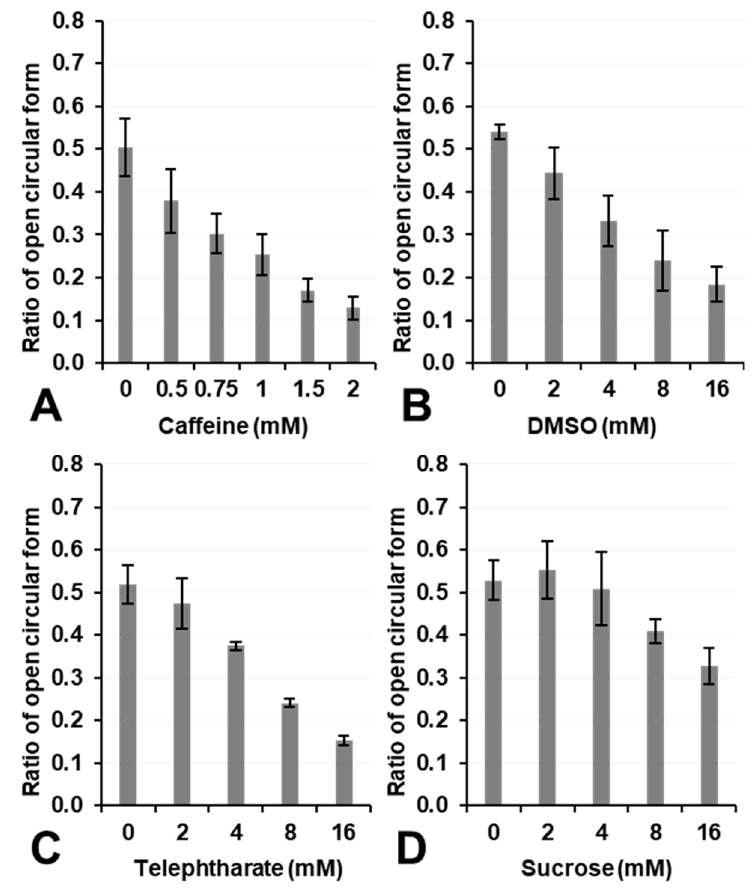
Figure 7. Effects of • OH scavengers on plasmid DNA breakage induced by UV irradiation in samples containing H 2 O 2 . The ratio of DNA breakage was suppressed in a concentration-dependent manner